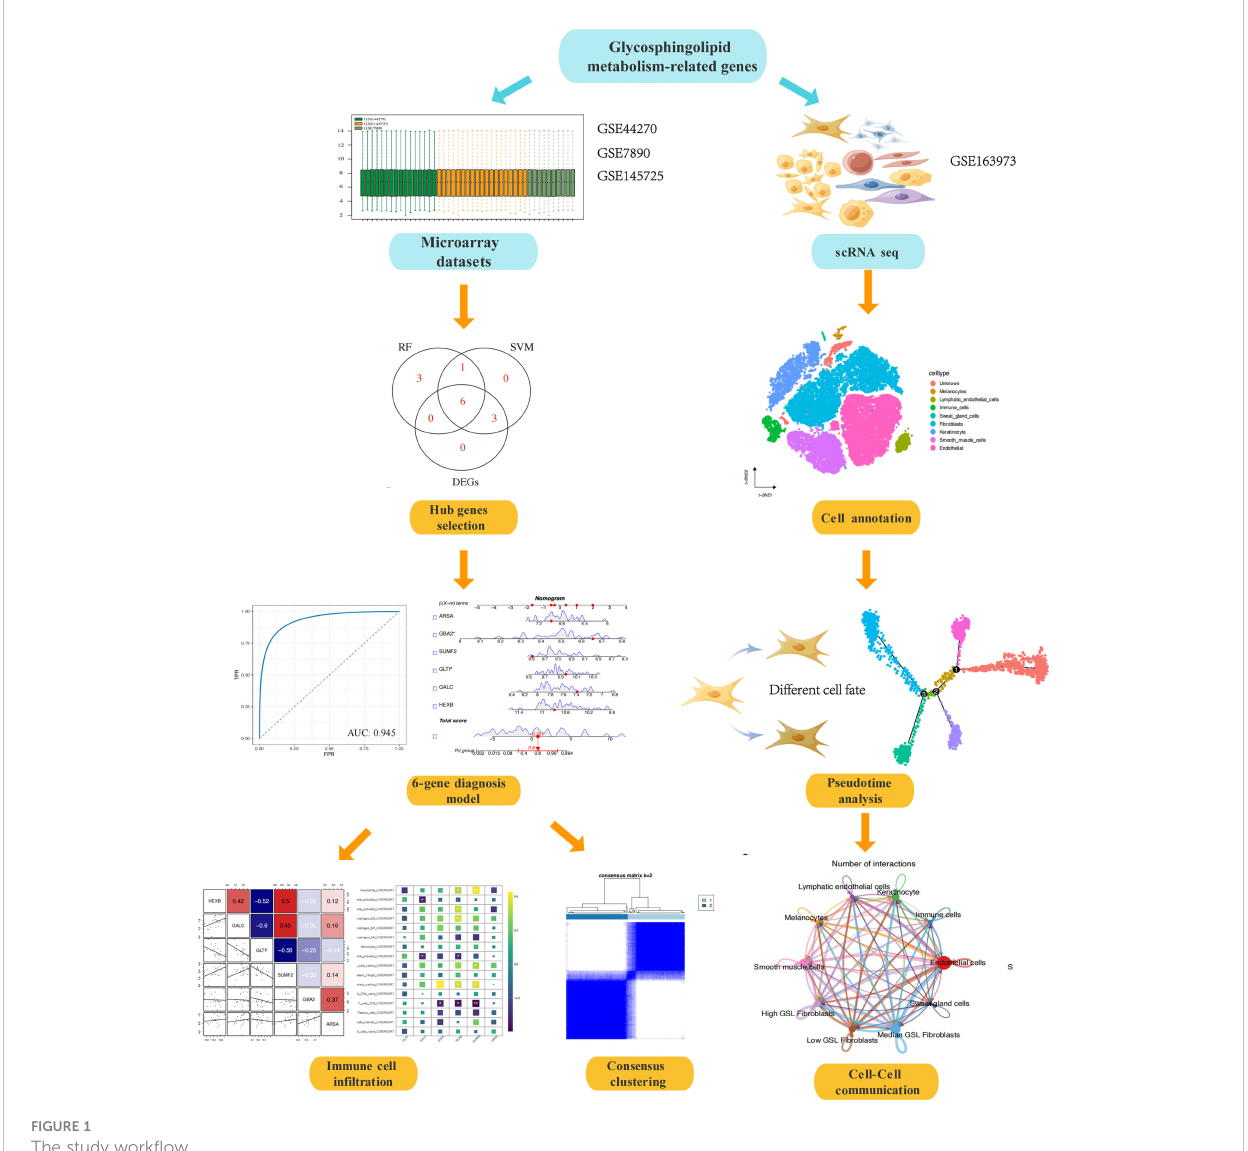
FIGURE 1 The study work fl